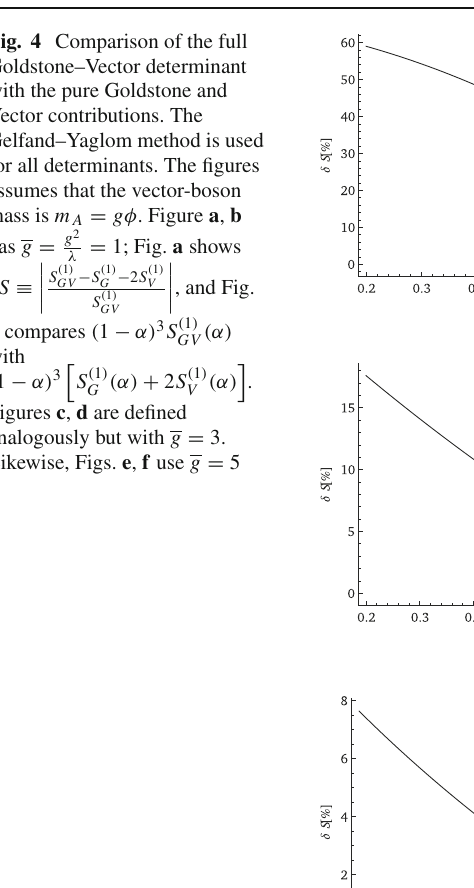
Figures c , d are defined analogously but with g =